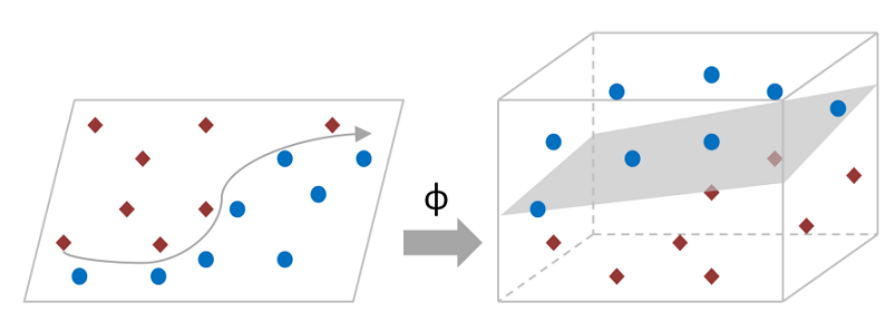
Figure 4. Feature space transformation [54],